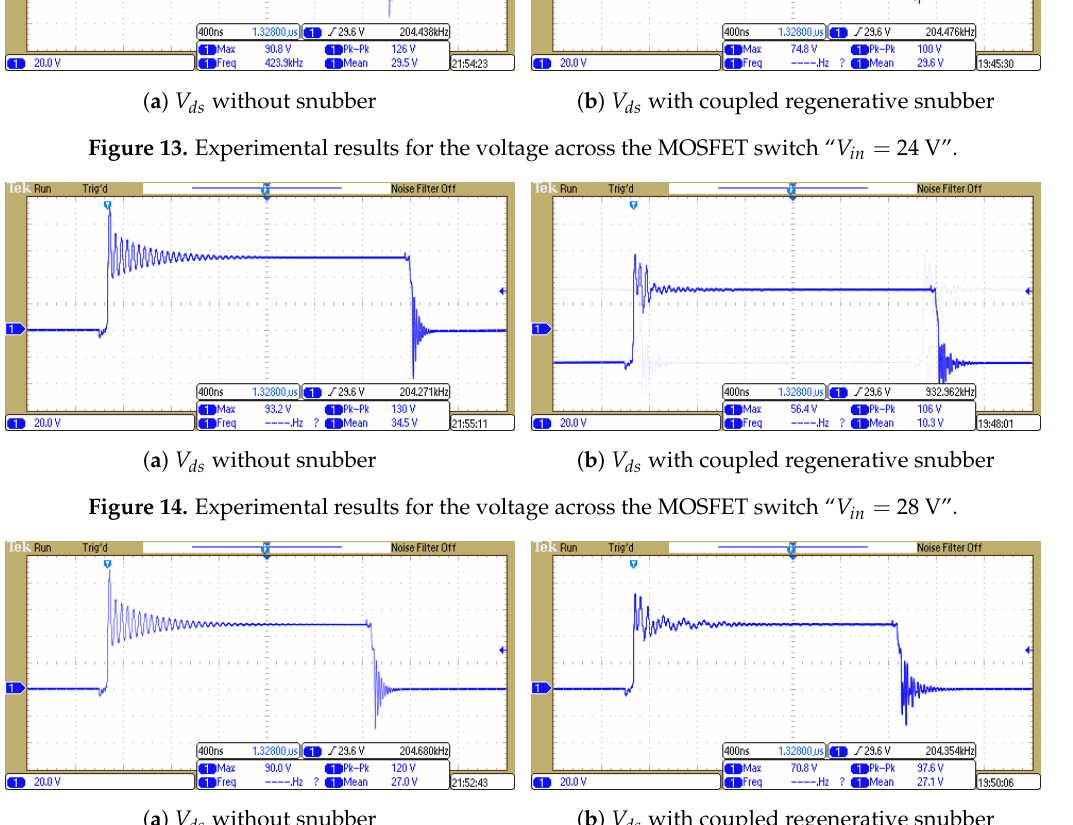
Figure 15. Experimental results for the voltage across the MOSFET switch “ V in = 22